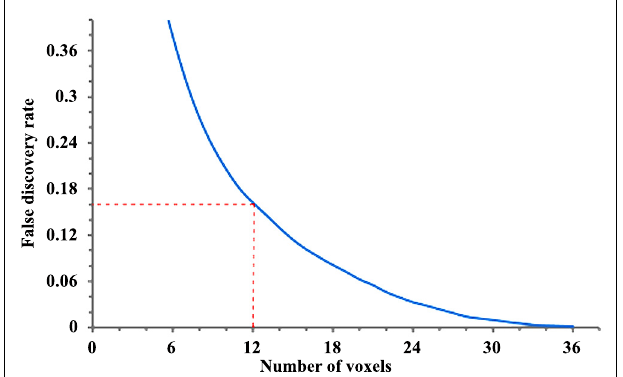
FIGURE 1 | Length threshold as defined by number of voxels in relation to the “false discovery rate” (FDR; each voxel = 2 mm). A length threshold of 24 mm corresponding to 12 voxels was chosen, therefore leading to an FDR of